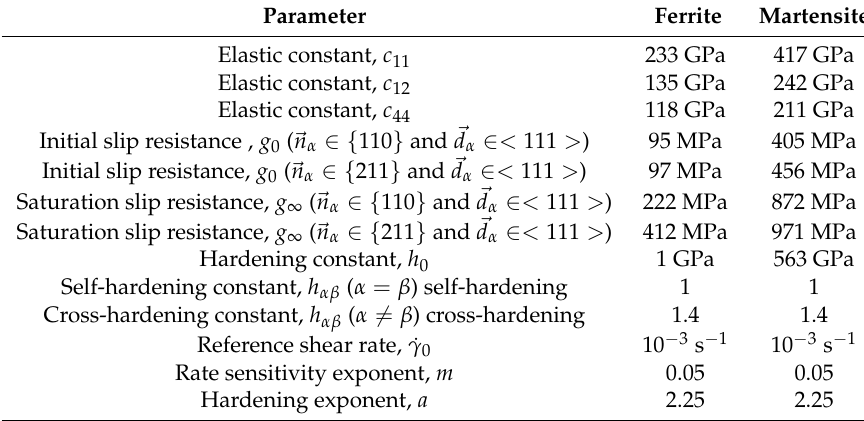
Table 1. Phenomenological crystal plasticity model parameters for martensite and ferrite [1].